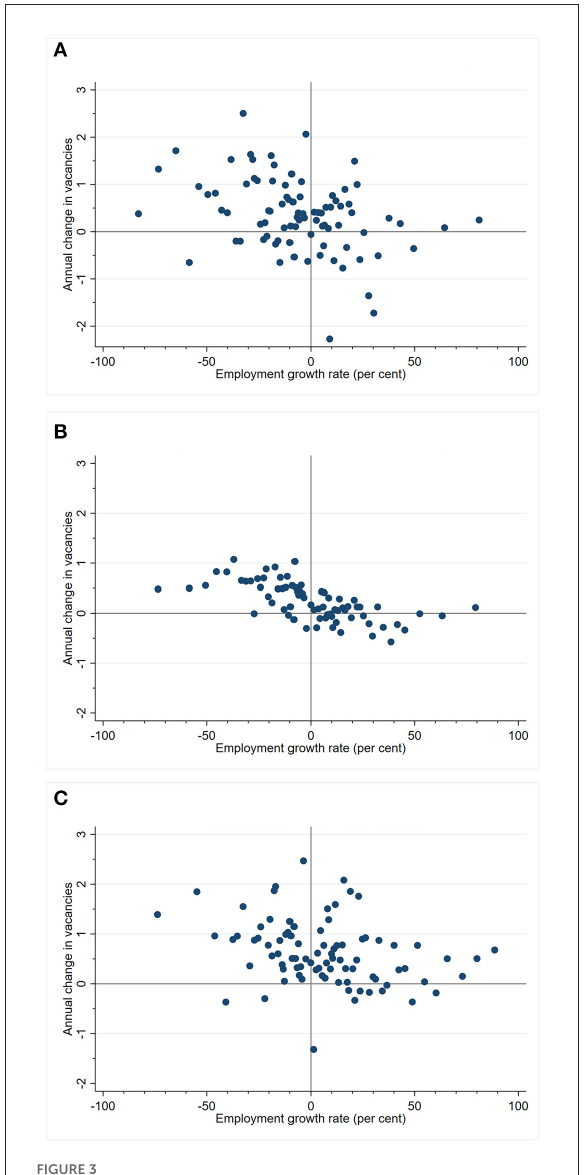
FIGURE3 Relationship between unfilled vacancies and employment growth: (A) Establishments with decrease in service utilization. (B) Establishments with no change in service utilization. (C) Establishments with increase in service